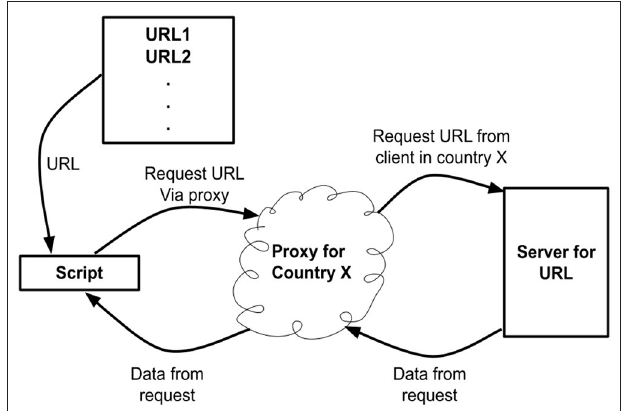
FIGURE 4 | Schematic of software used to download data.